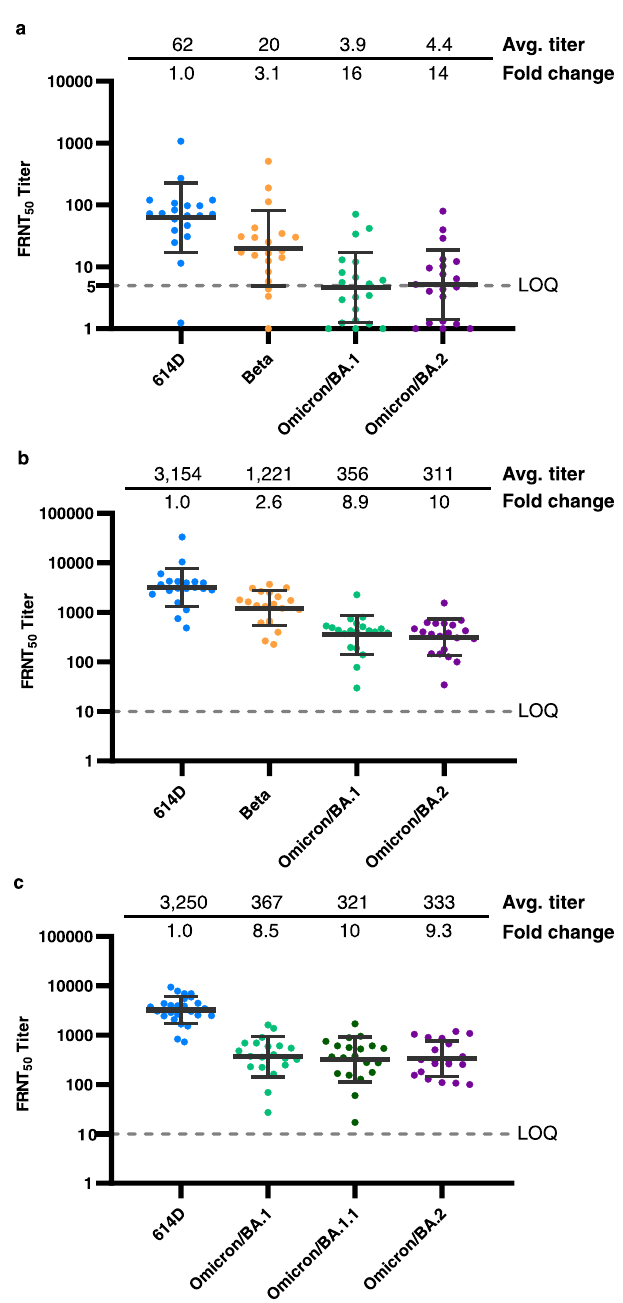
showed a difference between the reporter virus and the clinical isolate, which had an approximate 3-fold reduction versus 1 – 1.2- fold reduction in neutralizing titers, respectively (Fig. 2a, b). The Lambda variant has at least 14 substitutions/deletions in the spike protein (Supplementary Table 1) and the limited resistance to neutralization (1 – 1.2-fold) of clinical isolates was surprising. Two Lambda clinical isolates (Fig. 2b, Lambda (S1) and (S2)) with slightly different spike sequences were analyzed (Supplementary Table 1), and the results were consistent. The reporter SARS- CoV-2 system is powerful because the only difference between the viruses being analyzed is the spike, whereas natural isolates contain differences throughout the genome. It ’ s possible that changes in other gene products (e.g., membrane protein or envelope protein) could impact neutralization phenotype, but this remains to be understood.